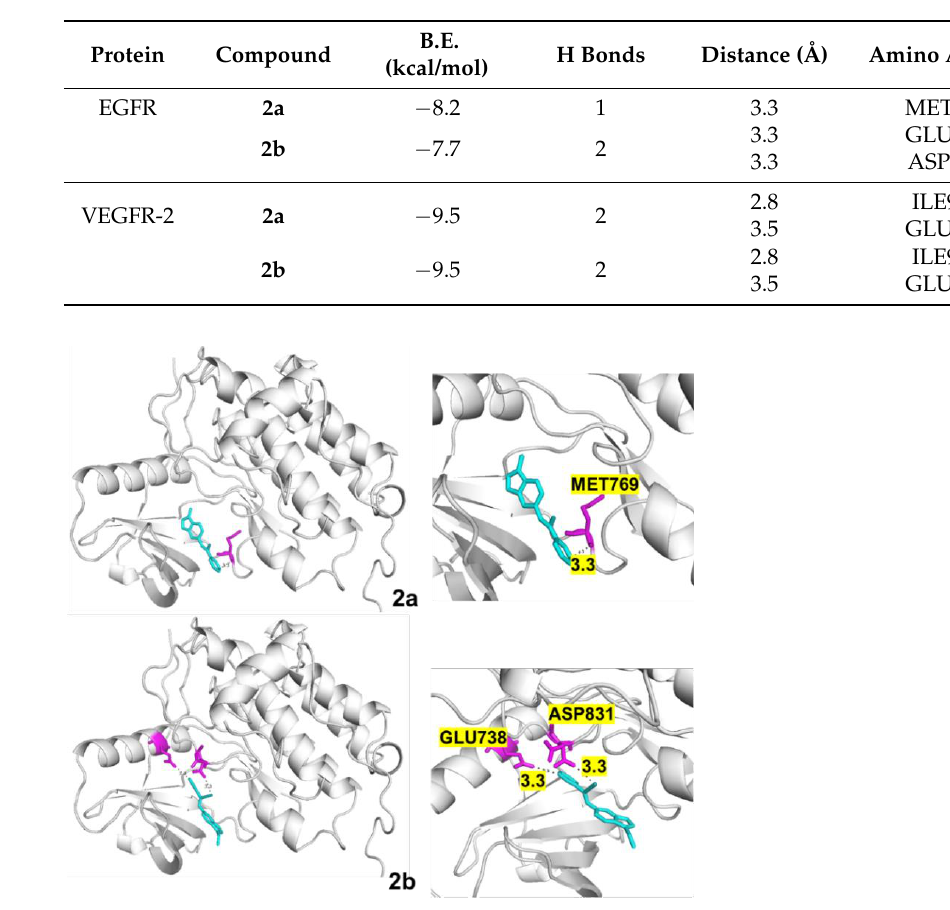
Table 3. Binding energies (B.E.) and H bond information for 2a and 2b when docked into EGFR and VEGFR-2.